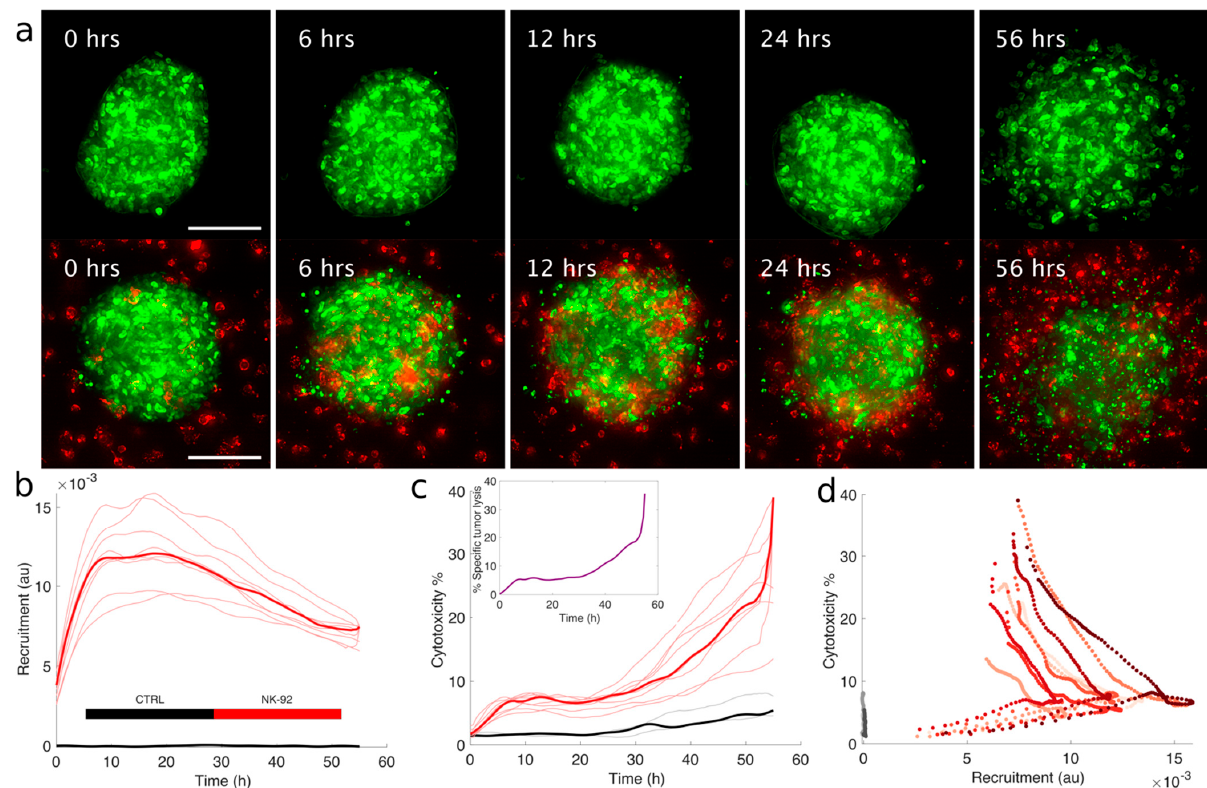
Figure 4. Quantitative characterization of tumor-specific cytotoxic activity of lymphocytes in 3D Mel. ( a ) Snapshots of mMel2-H2B-GFP spheroids alone (top) or co-cultured with NK-92 cells in 3D (bottom). Green signal corresponds to H2B-GFP while red signal comes from PKH26 labeling. Images are maximum intensity projections of a deconvolved z-stack time lapse. Scale bar: 100 μ m. ( b ) The plot illustrates the recruitment of NK-92 cells on mMel2 spheroids as reported by the fluorescence signal corresponding to single spheroids over time in control (black) vs. treated with NK-92 (red). Grey and light red correspond to single spheroids, while black and bright red correspond to averages. ( c ) Cytotoxicity for mMel2 left untreated (black) or co-cultured with NK-92 (red) as a function of time, calculated as the fraction of fragmented nuclei over the total amount of nuclei in each image, digitally segmented. Grey and light red correspond to single spheroids, while black and bright red correspond to averages. The inset shows a surrogate of the tumor-specific killing, calculated by assuming that fully eradicated tumors correspond to 100% of nuclei fragmented. ( d ) Scatterplot of recruitment vs. cytotoxicity. These curves are V-shaped because recruitment tends to be a non-monotonic function of time, while the curve for cytotoxicity is. This indicates that the bulk of the cytotoxic effect is not synchronous with the beginning of recruitment. Shades of grey and red correspond to the different spheroids plotted in panels ( b , c ).